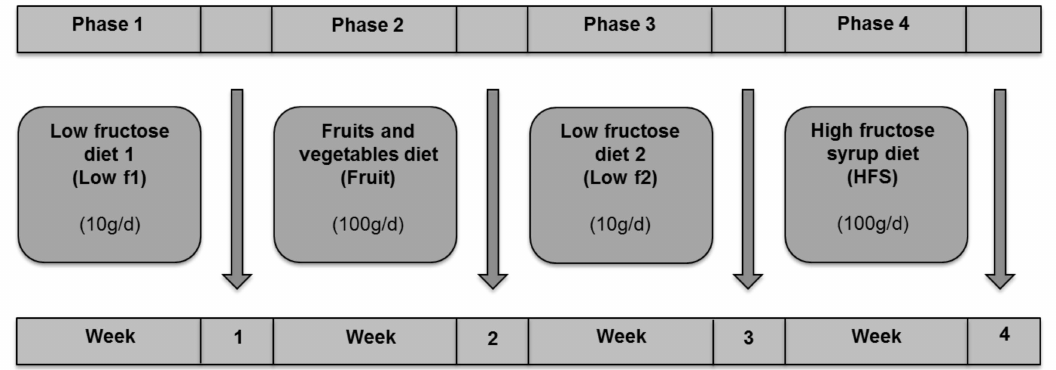
Figure 1. Study design. Study subjects received a low-fructose diet 1 (low f1), a fruits and vegetables diet (fruit), a low fructose diet 2 (low f2) and a high-fructose syrup diet (HFS).